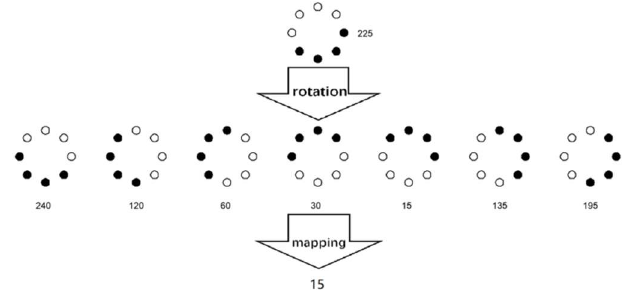
Figure 5. Rotation invariant LBP diagram.